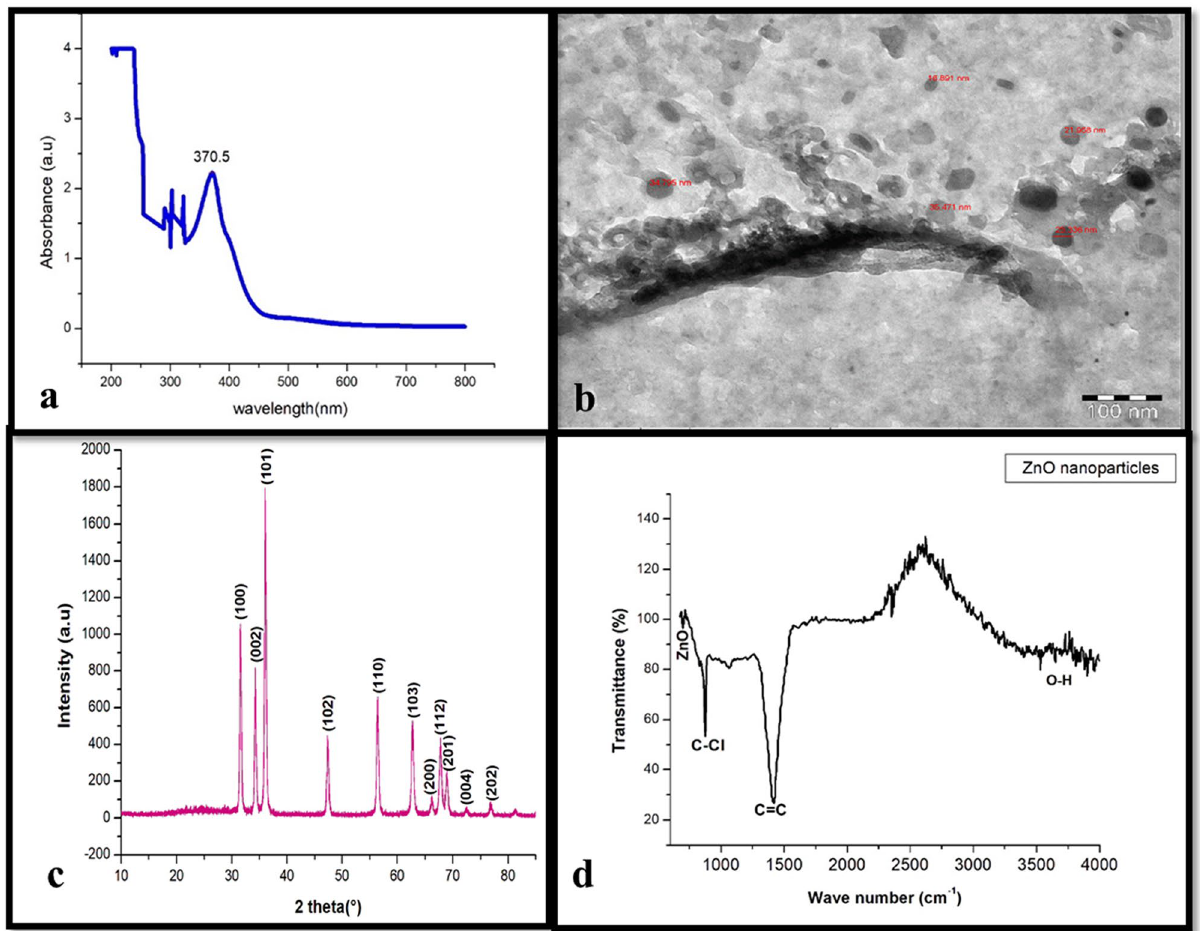
Figure 1. ( a ) UV-Visible absorption spectrum of the biosynthesized ZnO NPs (from 200 to 800 nm) band at 370.5 nm ( b ) TEM image of the biosynthesized ZnO NPs. Bar 100 nm ( c ) XRD Patterns of the biosynthesized ZnO NPs (from 10 to 85 2theta (°)) and ( d ) FTIR Spectrum of biosynthesized ZnO NPs (from 600 to 4000 cm −1